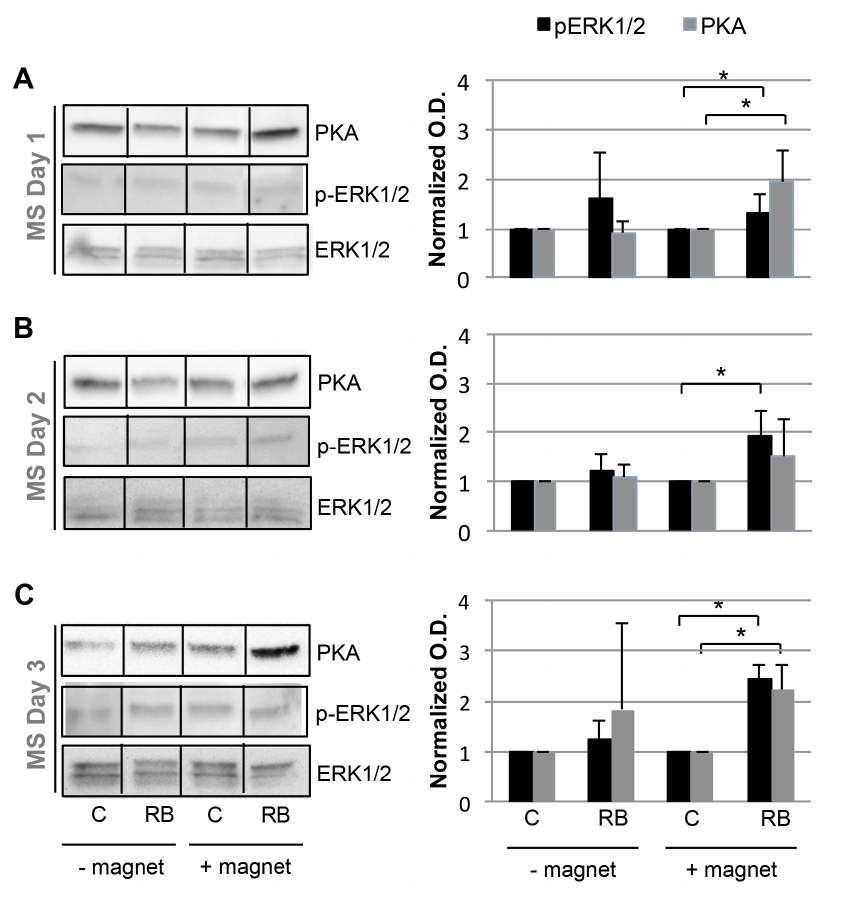
Fig. 5. Expression of PKA and phosphorylated ERK1/2 in response to magnetic attraction at different stages of EB development. Western blot analysis of EBs stimulated on Day 1 (A), Day 2 (B) or Day 3 (C). Protein expression was normalized to ERK. MS: mechanical stimulation, C: control, RB: RGD-Beads. * p , 0.05. Raw data is presented in S3 Figure.